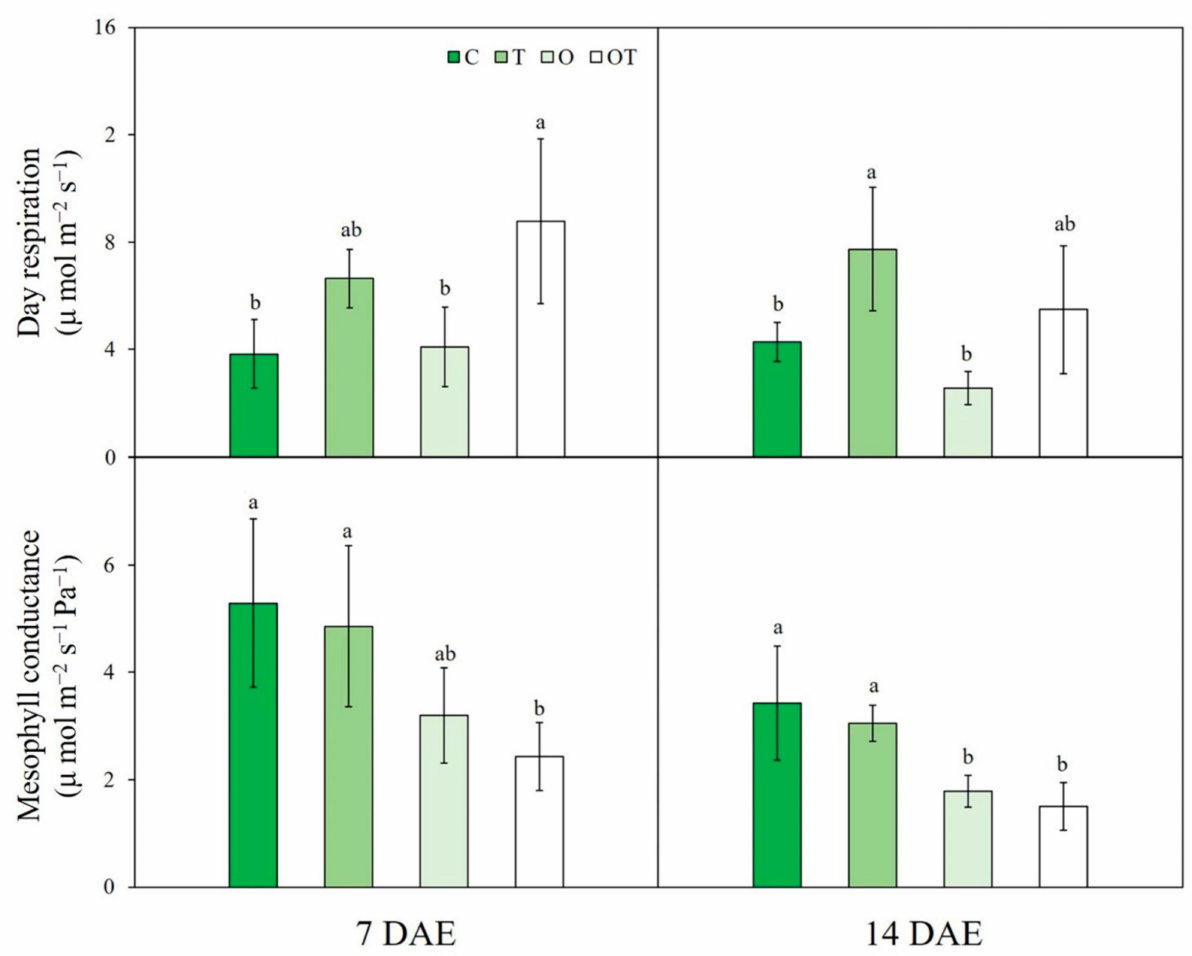
Figure 3. Daytime respiration and mesophyll conductance of Brassica juncea L. under different ambient and supraoptimal temperatures and O 3 concentrations at 7 and 14 DAE. Data are plotted as mean ± SD ( n = 5). Different letters indicate significant differences among treatments at p < 0.05 according to Tukey’s honestly significant difference test. C: ambient O 3 + optimal temperature; T: ambient O 3 + supraoptimal temperature; O: elevated O 3 + optimal temperature; OT: elevated O 3 + supraoptimal temperature; DAE: days after the beginning of